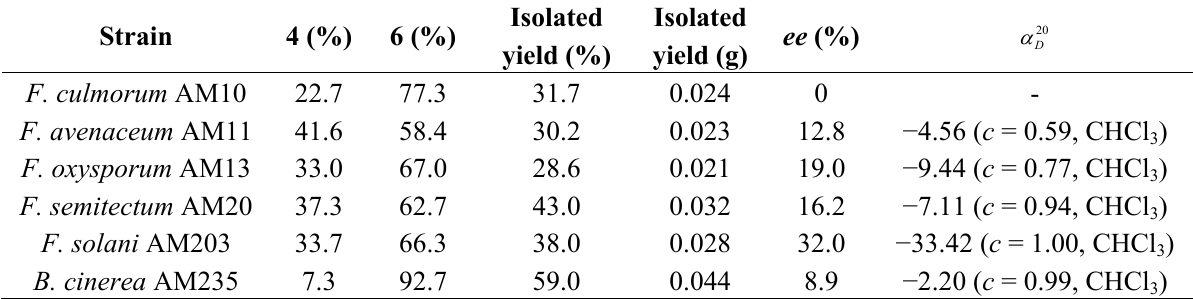
Table 3. Results of preparative biotransformations of lactone 4 after 14